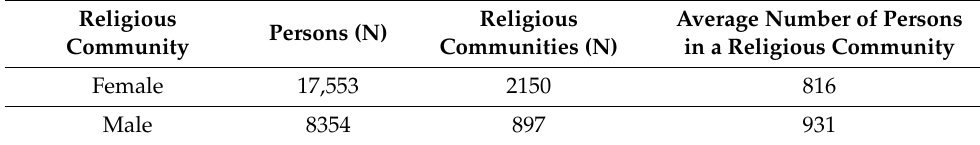
Table 1. Number of consecrated persons in Poland.